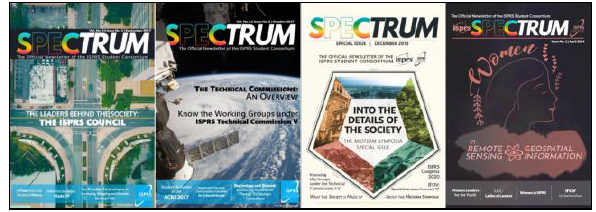
Figure 5. The special issues of SpeCtrum, the official Newsletter of the ISPRS Student Consortium.